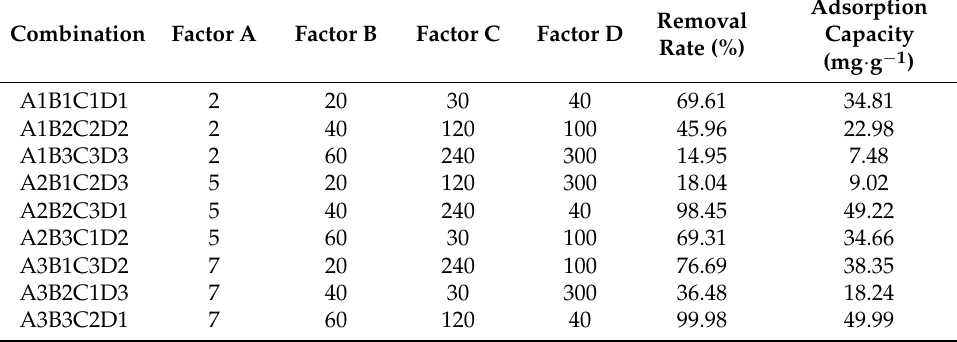
Table 7. Orthogonal experiment design and experimental results.